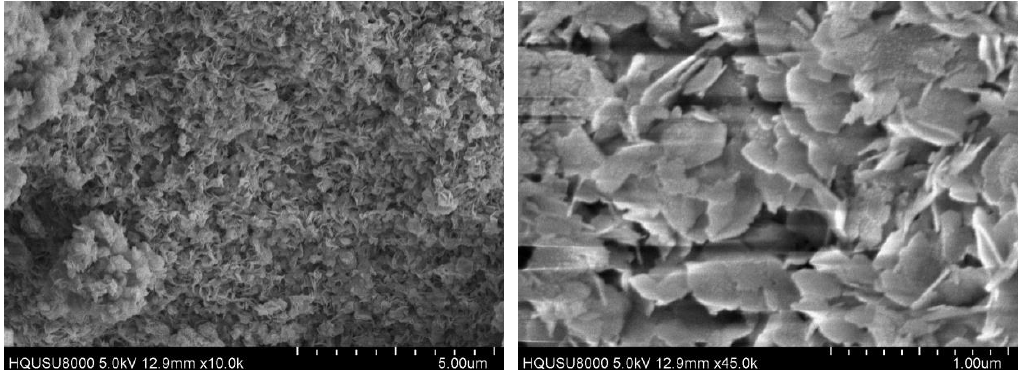
Figure 6. SEM images of the K + /HT with different resolutions.